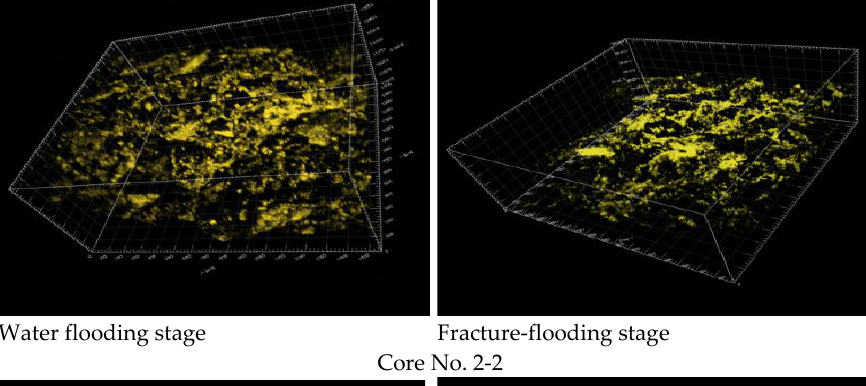
Table 4. Relative percentage of remaining oil distribution.